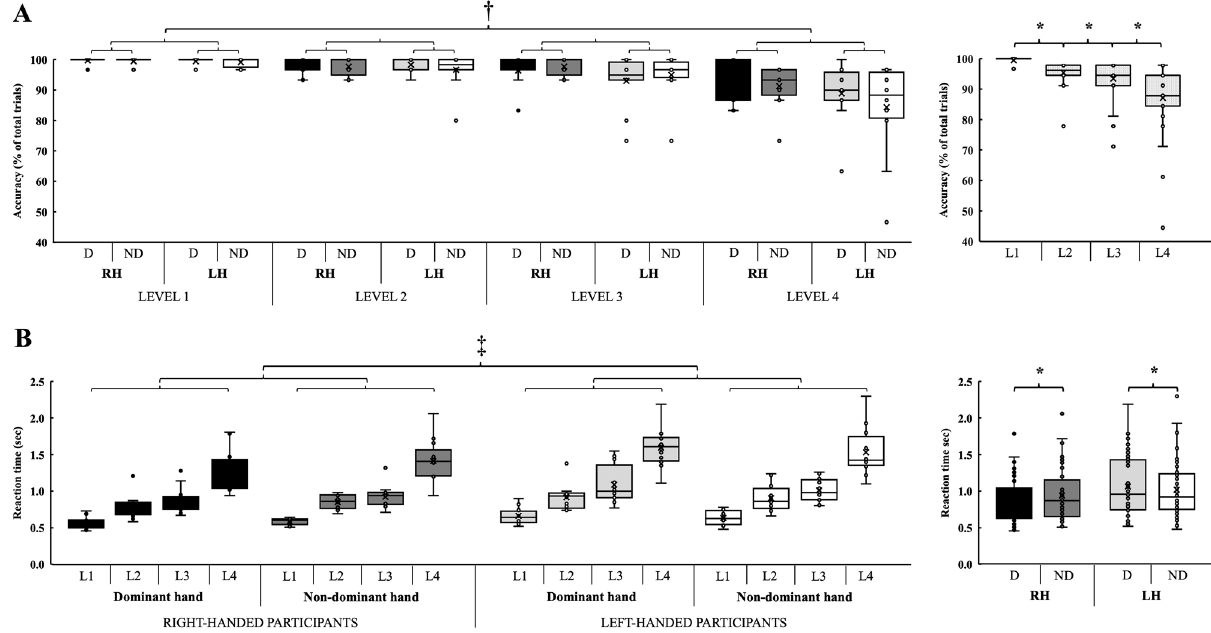
Figure 3. The effects of handedness and sequence complexity on accuracy and reaction time. Panel ( A ) Accuracy, determined by the percent of correct motor sequences decreased with the increase in sequence complexity, regardless of handedness. Panel ( B ) Both right- and left-handed participants performed the motor sequence task with less RT when using their right hand. D: dominant hand; L: sequence complexity level; LH: left-handed participants; ND: non-dominant hand; RH: right-handed participants The boxplots show the median, the upper, and lower quartiles, and the min and max value of the groups. “ × ” within the boxplot represents the mean line. ‡ handedness × hand interaction effect; † main effect of sequence complexity, * p <